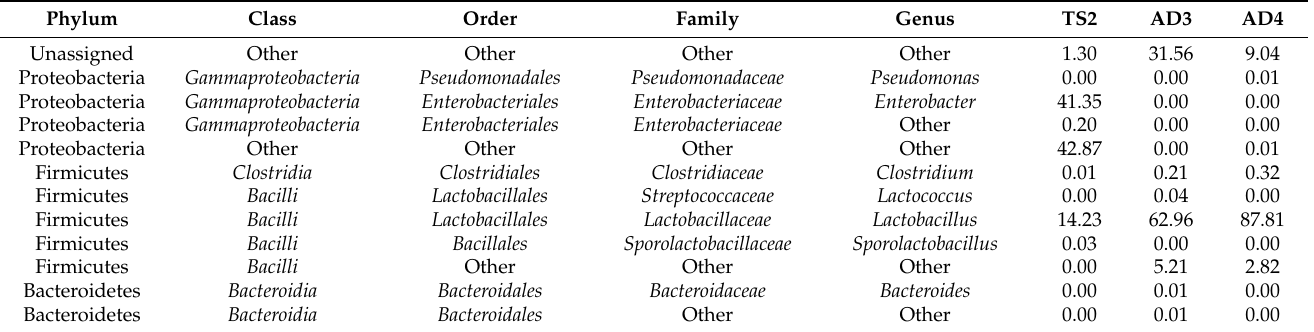
Figure 3. Relative abundance of main bacterial groups as obtained by barcoded sequencing of 16S rRNA amplified from hydrogen-producing consortia TS2, AD3, and AD4. Table 4. Detailed analysis of the bacterial community by pyrosequencing. Taxonomic assignments obtained by comparison with the database of 16S rRNA sequences deposited in SILVA [38]. Values are indicated as percentage.